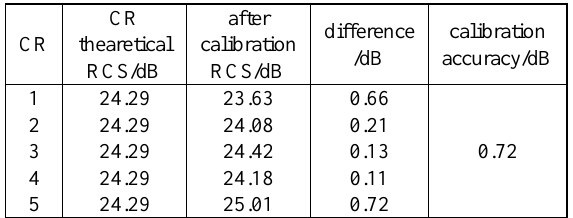
Table.6 Peak method Absolute Calibration Accuracy Verification